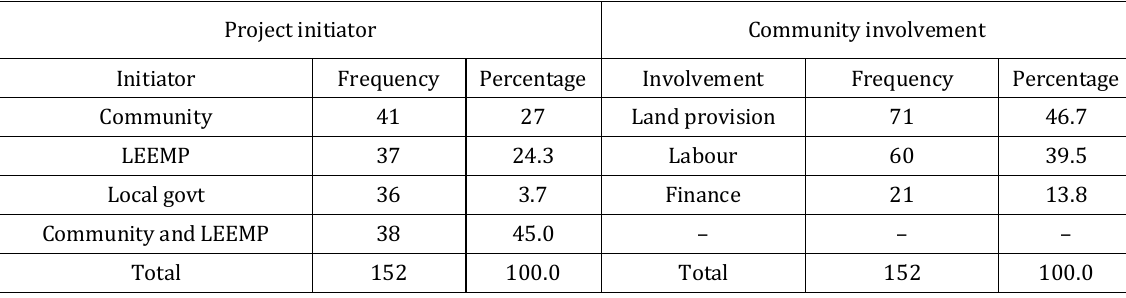
Table 2. Project initiator and community